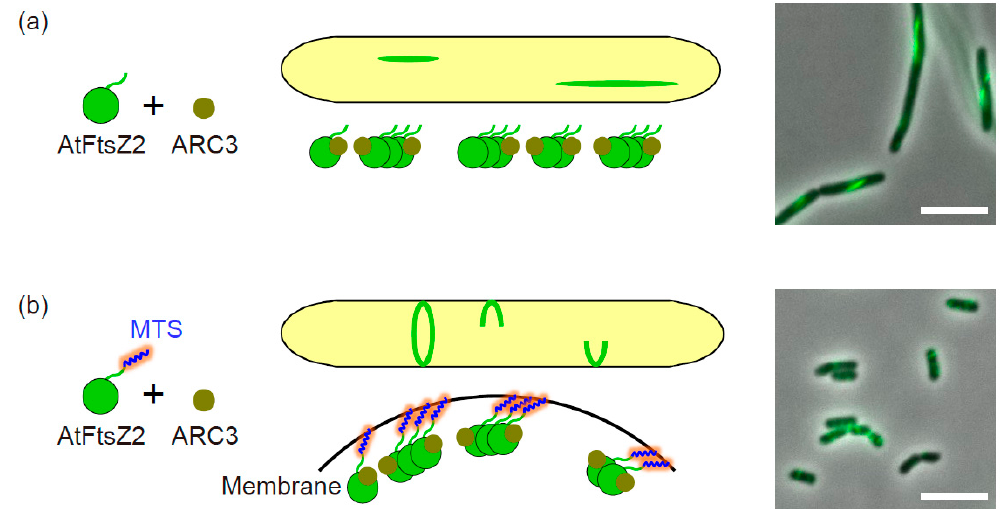
Figure 2. The effects of Accumulation and Replication of Chloroplasts 3 (ARC3) on the filaments of Arabidopsis chloroplast FtsZ2 in the bacterial heterologous expression system. Schematic illustration of the proposed molecular behavior of chloroplast division-related components in E. coli cells and its merged microscopic image of phase-contrast and GFP are shown when expressing ( a ) sfGFP-AtFtsZ2 and ARC3, and ( b ) sfGFP-AtFtsZ2-2MTS and ARC3. E. coli cells were grown in L broth (1% bactotryptone, 0.5% yeast extract, 0.5% NaCl) to the stationary phase at 22 °C. Scale bars: 5 µm. MTS: membrane-targeting sequence. To reduce the complexity in the diagrams, bundling of the FtsZ2 filaments was omitted.